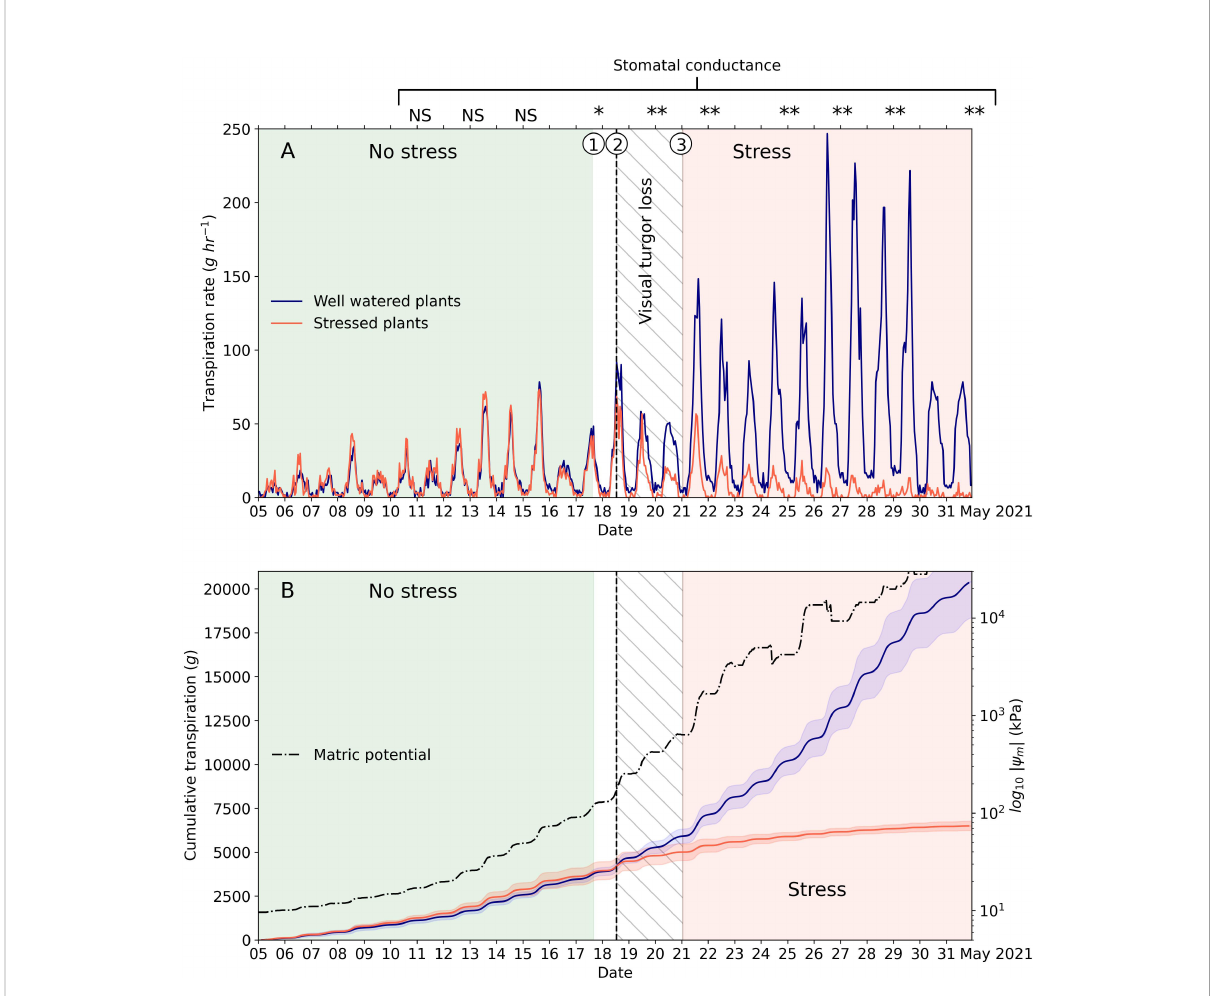
FIGURE 4 Transpiration rate (A) and cumulative transpiration (B) for well-watered and stressed plants of Palmer amaranth. The graphs shows the periods in which plants were clearly under no stress (light green area) and under stress (light orange area) due to soil water de fi cit. The fi gure also shows the onset at which stressed plants started to exhibit lower transpiration rates (vertical dashed line, point ② ) than well-watered plants. The central white area represents a period of about 3 days in which plants started to exhibit evidence of water stress. Point ① represents the date at which we fi rst detected signi fi cant differences in stomatal conductance between treatments. The interval between points ② and ③ (hatched area) represents a 58-hour period during which visual signs of turgor loss were observed for the fi rst time in the stressed treatment. Between points ① and ③ the transpiration rate depended on the interaction between soil moisture conditions and atmospheric demand. The shaded area around cumulative transpiration curves represent the 95% con fi dence intervals based on six replicates. The soil matric potential is the median value of the six replicates. For the measurements of stomatal conductance, NS means non-signi fi cantly different at the 5% level, * means P<0.05 , and ** means signi fi cant at P<0.01 using an independent two-sample t